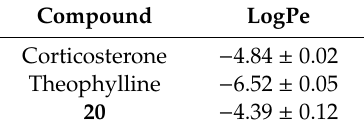
Table 3. logPe represents the PAMPA effective permeability coefficient results for 20 .